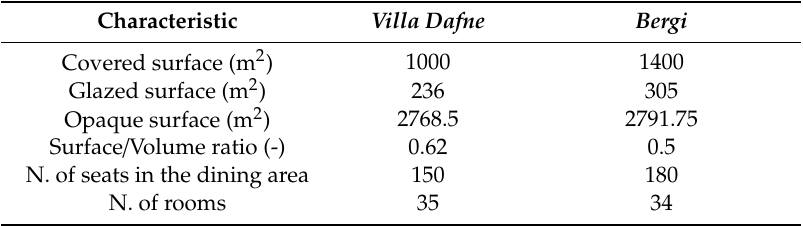
Table 2. General characteristics of the two selected agritourisms.